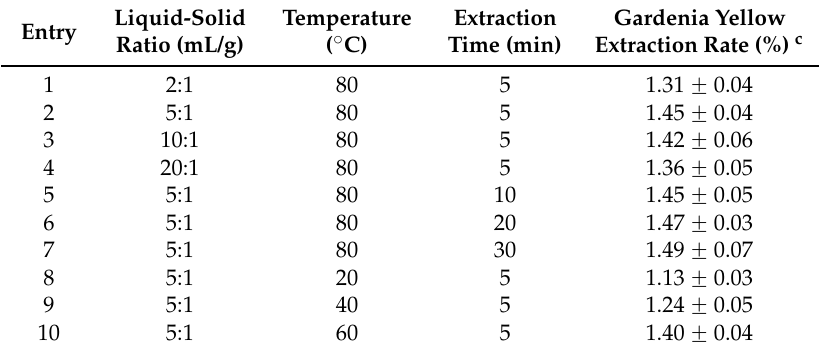
Table 3. The influence of extraction conditions on yield of gardenia yellow in 80% ethanol solution a,b